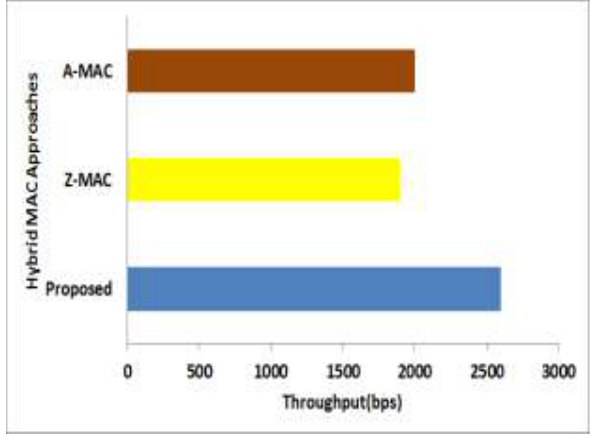
Figure 4. Comparative Analysis of